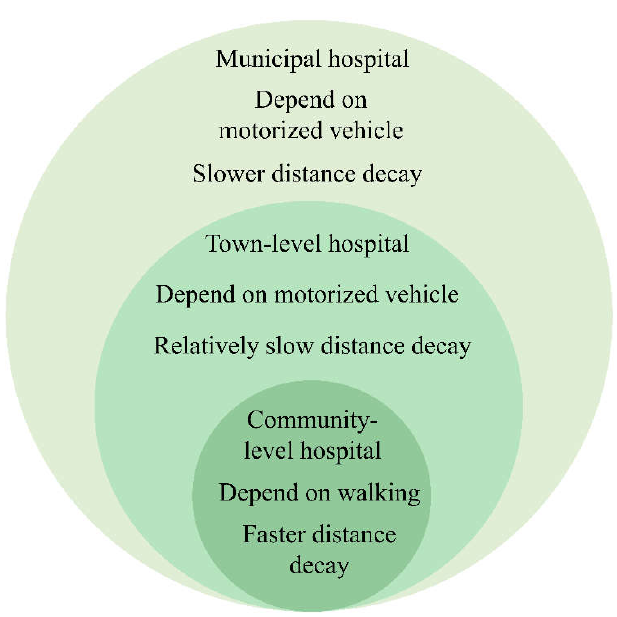
Figure 3. Schematic display of the attractive ranges for the three medical service levels in Shenzhen.